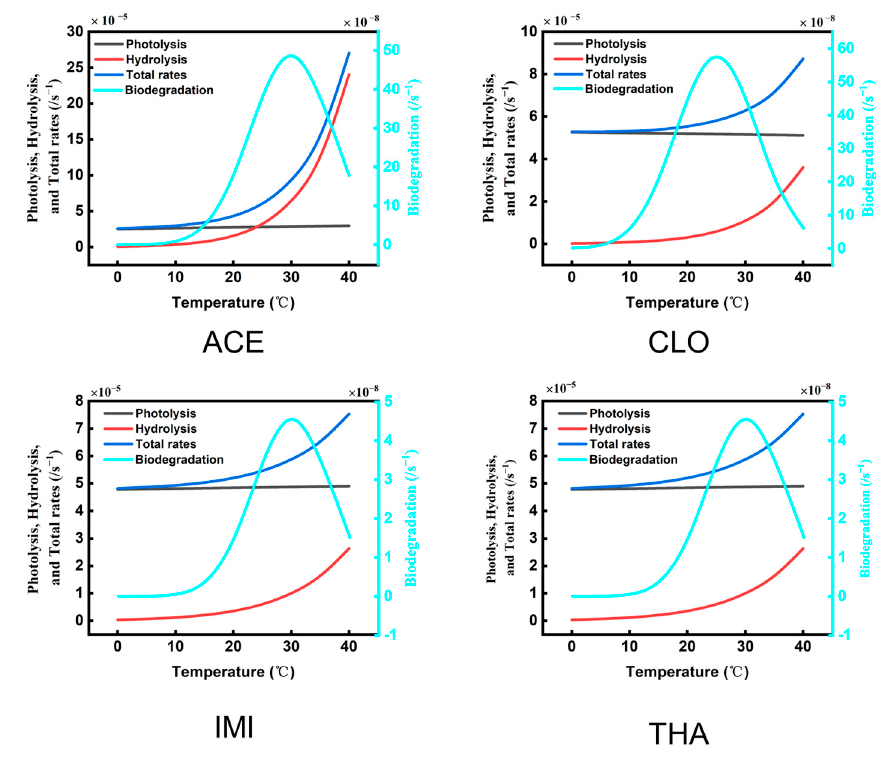
Figure 5. Effects of a single environment factor (temperature) on the degradation rates (total, photolysis, hydrolysis, and biodegradation rates) of the typical NEOs in the simulations.